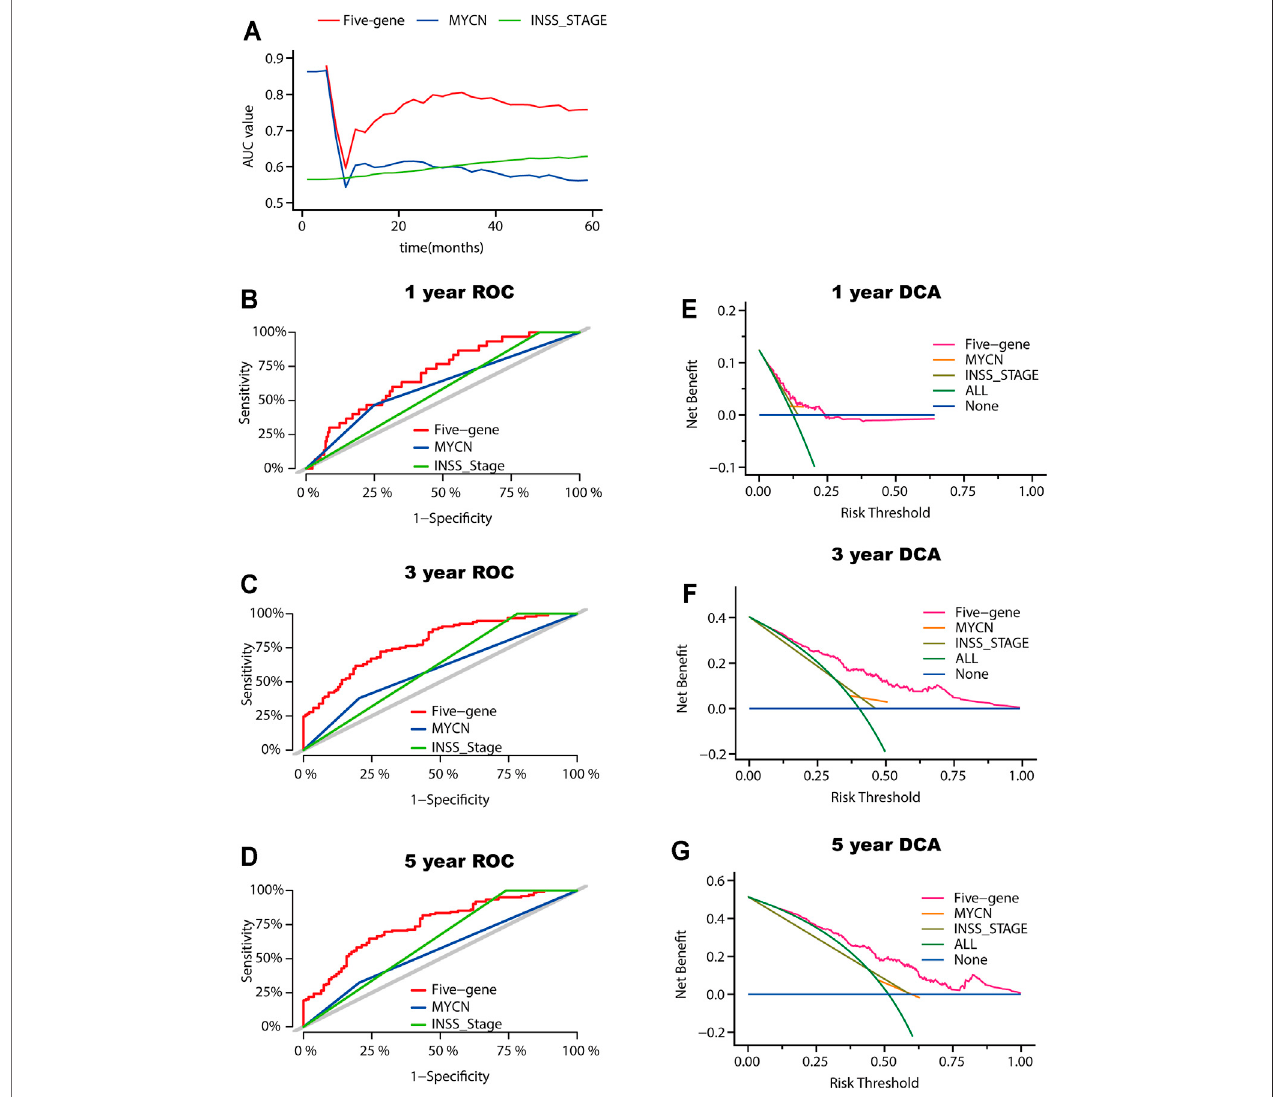
FIGURE6| Modelcomparisonbetweenthe fi ve-genesignature,theINSSstage,andtheMYCNstatus. (A) AUCofthe fi ve-genesignature,theINSSstage,andthe MYCN status. (B-D) ROC curves of the fi ve-gene signature of the INSS stage model and MYCN status for 1-year (B) , 3-year (C) , and 5-year (D) overall survival predictions. (E-G) DCA curves depicting the standardized net bene fi t of the fi ve-gene signature for INSS stage and MYCN status at 1 year (E) , 3 years (F) , and 5 years (G) .